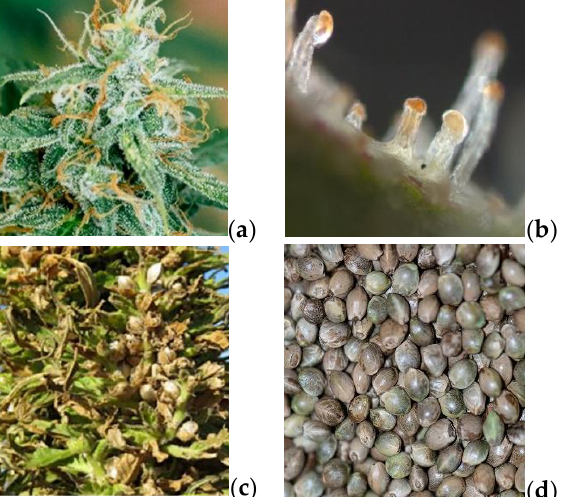
Figure 1. Hemp flower. Cannabinoid-rich female flower buds before pollination ( a ) and a microscopic image of the trichomes in the buds ( b ). The adult seeded flower is the result of pollination ( c ), and the hempseeds are produced by pollinated buds ( d ) .